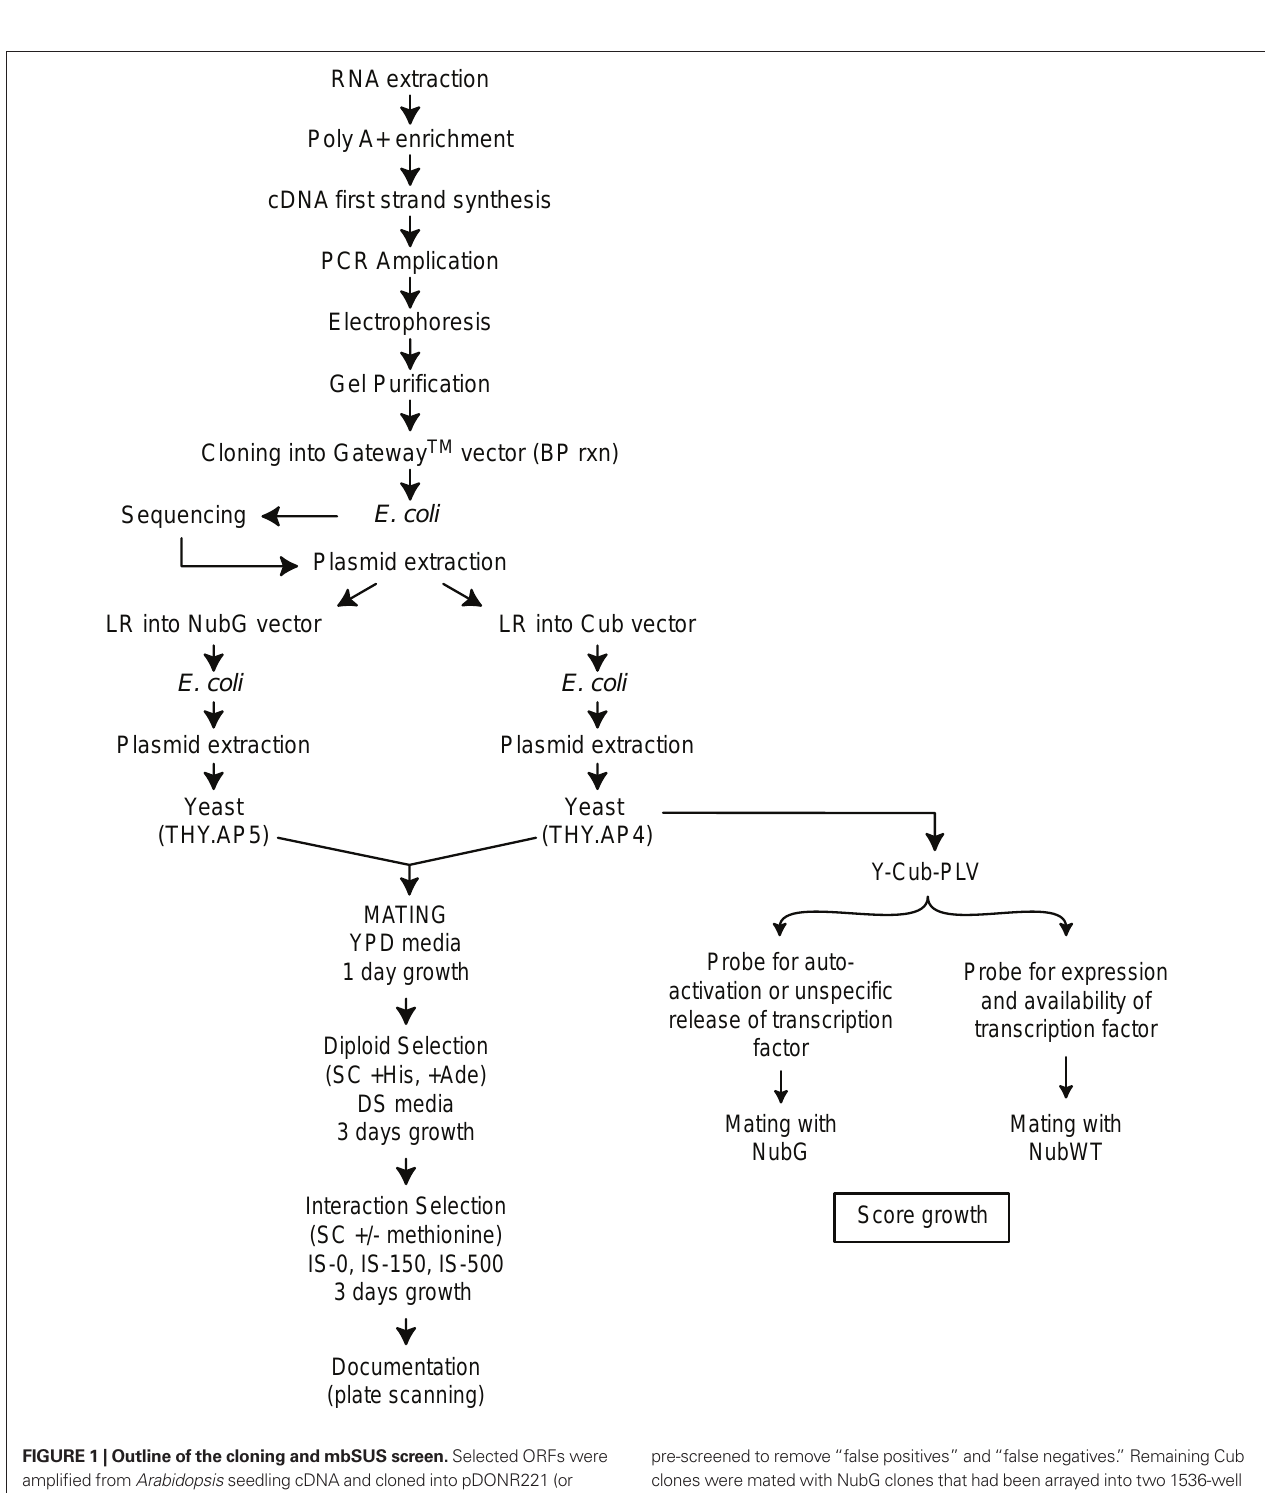
Figure 1 | Outline of the cloning and mbSuS screen. Selected ORFs were amplified from Arabidopsis seedling cDNA and cloned into pDONR221 (or pDONR221-f1) by Gateway recombination. ORFs that passed the quality control criteria were mobilized into Cub and NubG destination vectors and introduced into THY.AP4 and THY.AP5 yeast strains. Yeast expressing the Cub clones were